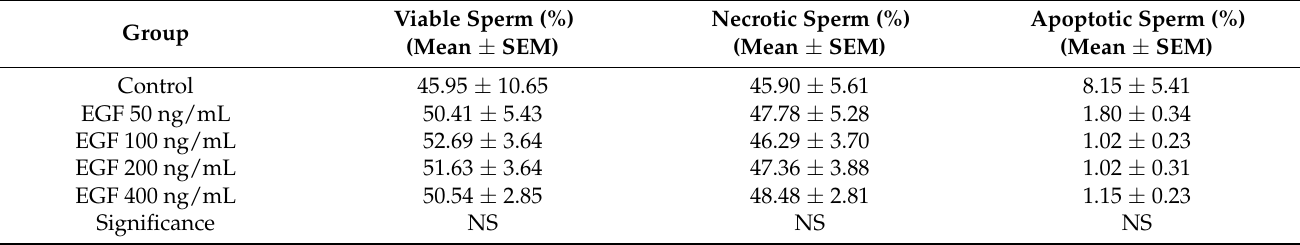
Table 5. Differences in apoptosis between thawed semen extended with epidermal growth factor (EGF) at different concentrations (50, 100, 200, and 400 ng/mL) and controls (without EGF) at different post-thaw times (n = 8 replicates).